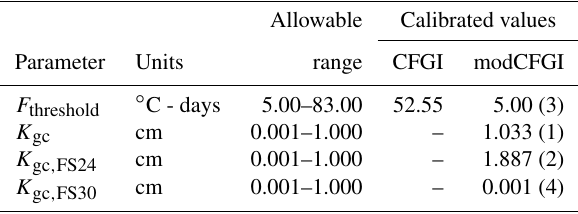
Table 2. Allowable ranges and calibrated values for the CFGI and modCFGI model parameters using PEST. Dashes indicate param- eters that are not required in the associated model. The sensitivity ranking for the modCFGI parameters are shown in parentheses.